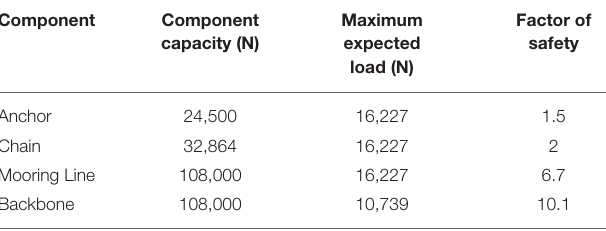
TABLE 2 | Component capacities, design loads, and resulting factors of